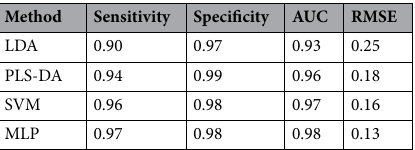
Table 2. Validation of a classifier using a supervised machine learning method for the classification of activation